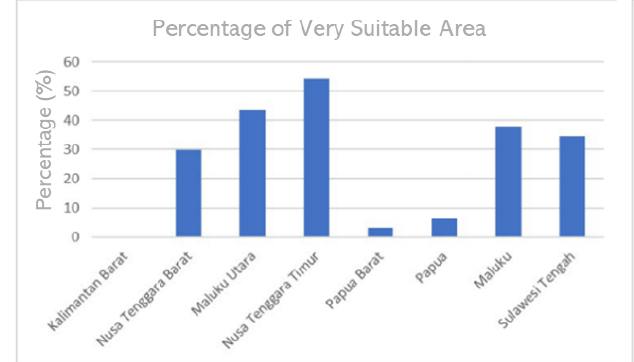
Figure 7 . Area Percentage of PLTS Development in Very High Suitability Class in 3T